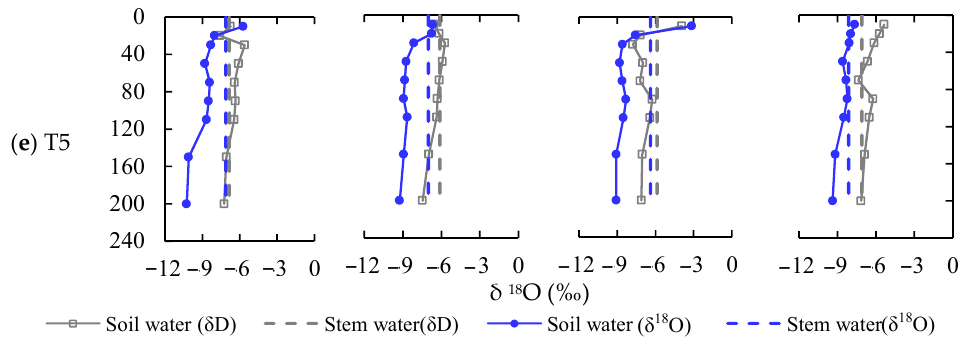
Figure 6. δ D and δ 18 O in soil water and stem water at each growth stage of winter wheat in the 2015 season for treatment: ( a ) T1, ( b ) T2, ( c ) T3, ( d ) T4, and ( e ) T5.